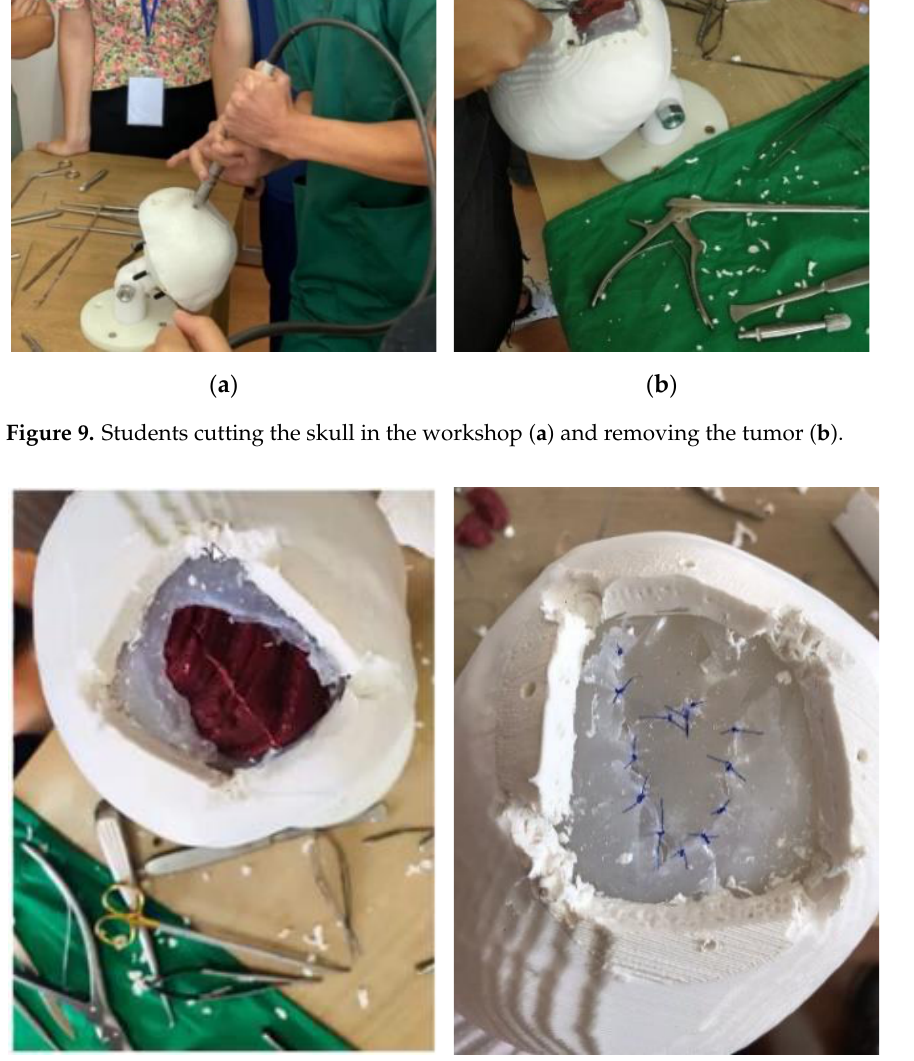
( b ) Figure 11. Final suture of the skull ( a ) with the tumor removed ( b ). All the steps of the real surgery were successfully reproduced. During the craniotomy time, the electric drill and specific cutting tools were used (Figure 9a). No difficulties were encountered in this surgical step, and the used material simulated the bone structure very well. The removal of the bony flap was followed by the incision of the dura mater, the thin membrane that covers the brain (Figure 9b). The next surgical step was the intracerebral tumor ablation. In this 3D reconstruction, the tumor had a hard consistency, and therefore the ablation was performed piece by piece, using cutting and dissecting tools (Figure 10a). Total removal of the well-defined tumor formation was performed, and the dura mater was sutured in place using simple interrupted stitches. The material used in this